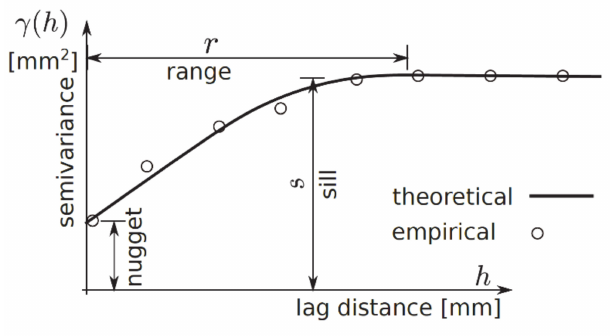
Figure 9. Semivariogam fitting and notation. 2.6. Geostatistical Model Fitting to Empirical Semivariogram—Surface Semivariogram Model